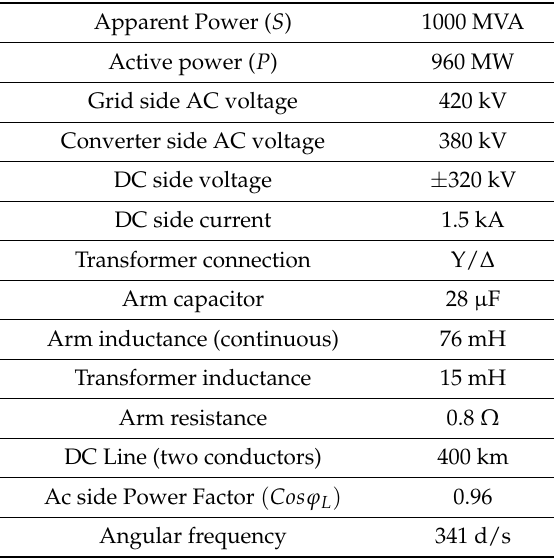
Table 2. HVDC System